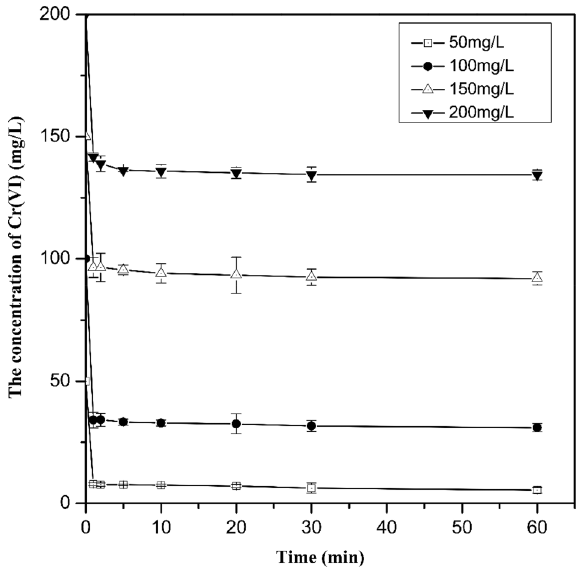
Figure 5. Effect of initial Cr(VI) concentrations on Cr(VI) removal by Cu/Fe bimetallic nanoparticles. Error bars indicate the standard deviation of the mean (n = 3).